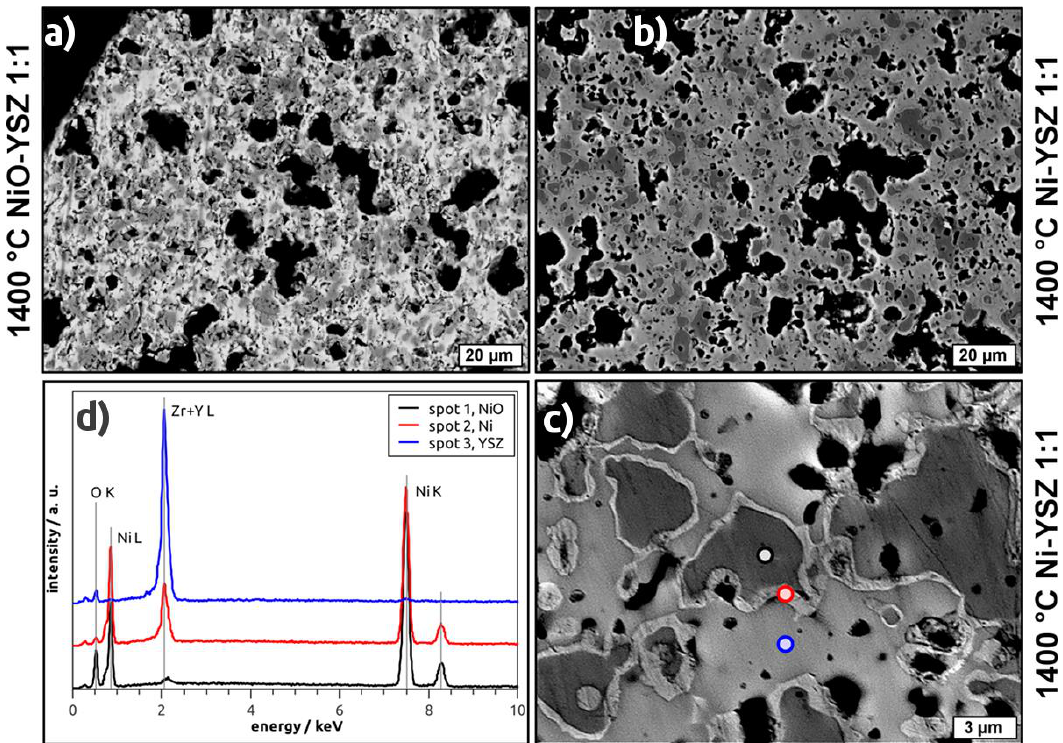
Figure 5. Backscattered electron micrographs of selected samples containing equal weight fractions of NiO and YSZ and sintered at 1400 °C before ( a ) and after reduction with H 2 ( b , c ), black regions correspond to pores inside the material; ( d ) energy-dispersive X-ray spectroscopy (EDS) spectra recorded on characteristic spots show the element distribution in the respective Ni/NiO/YSZ phases being present in the hydrogen-treated samples.